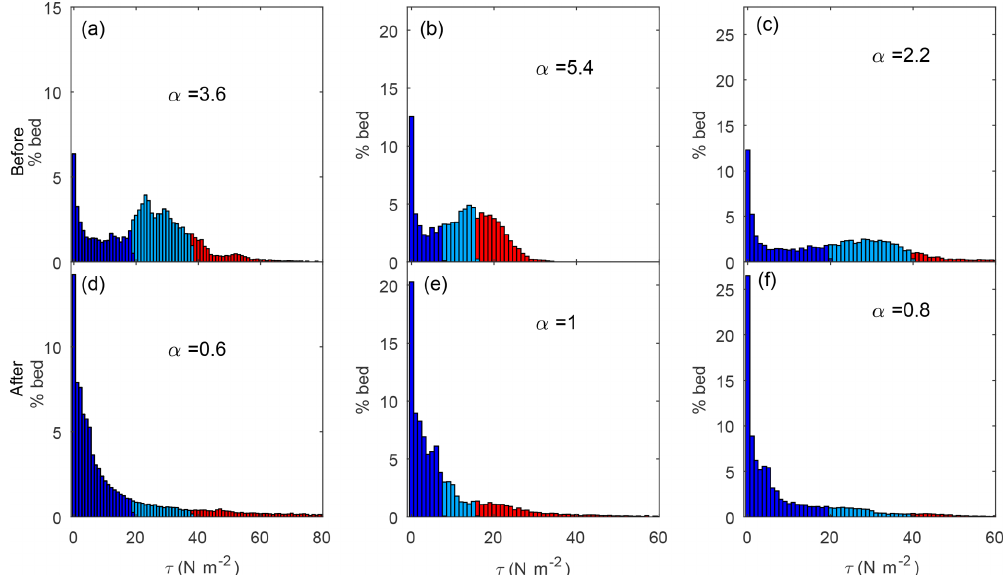
Figure 6. Shear stress ( τ ) distributions at bankfull flow at Sites 1 (a, d) , 2 (b, e) , and 3 (c, f) before (a–c) and after (d–f) the addition of large wood (LW). Alpha ( α ) parameters of the a gamma fit are provided. Dark blue corresponds to τ<τ c , light blue corresponds to τ c <τ< 2 τ c , and red corresponds to τ> 2 τ c